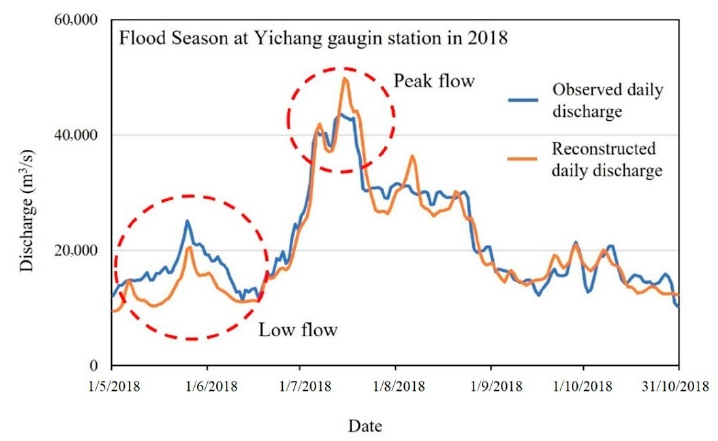
Figure 18. Daily discharge at the Yichang gauging station during flood season in 2008.